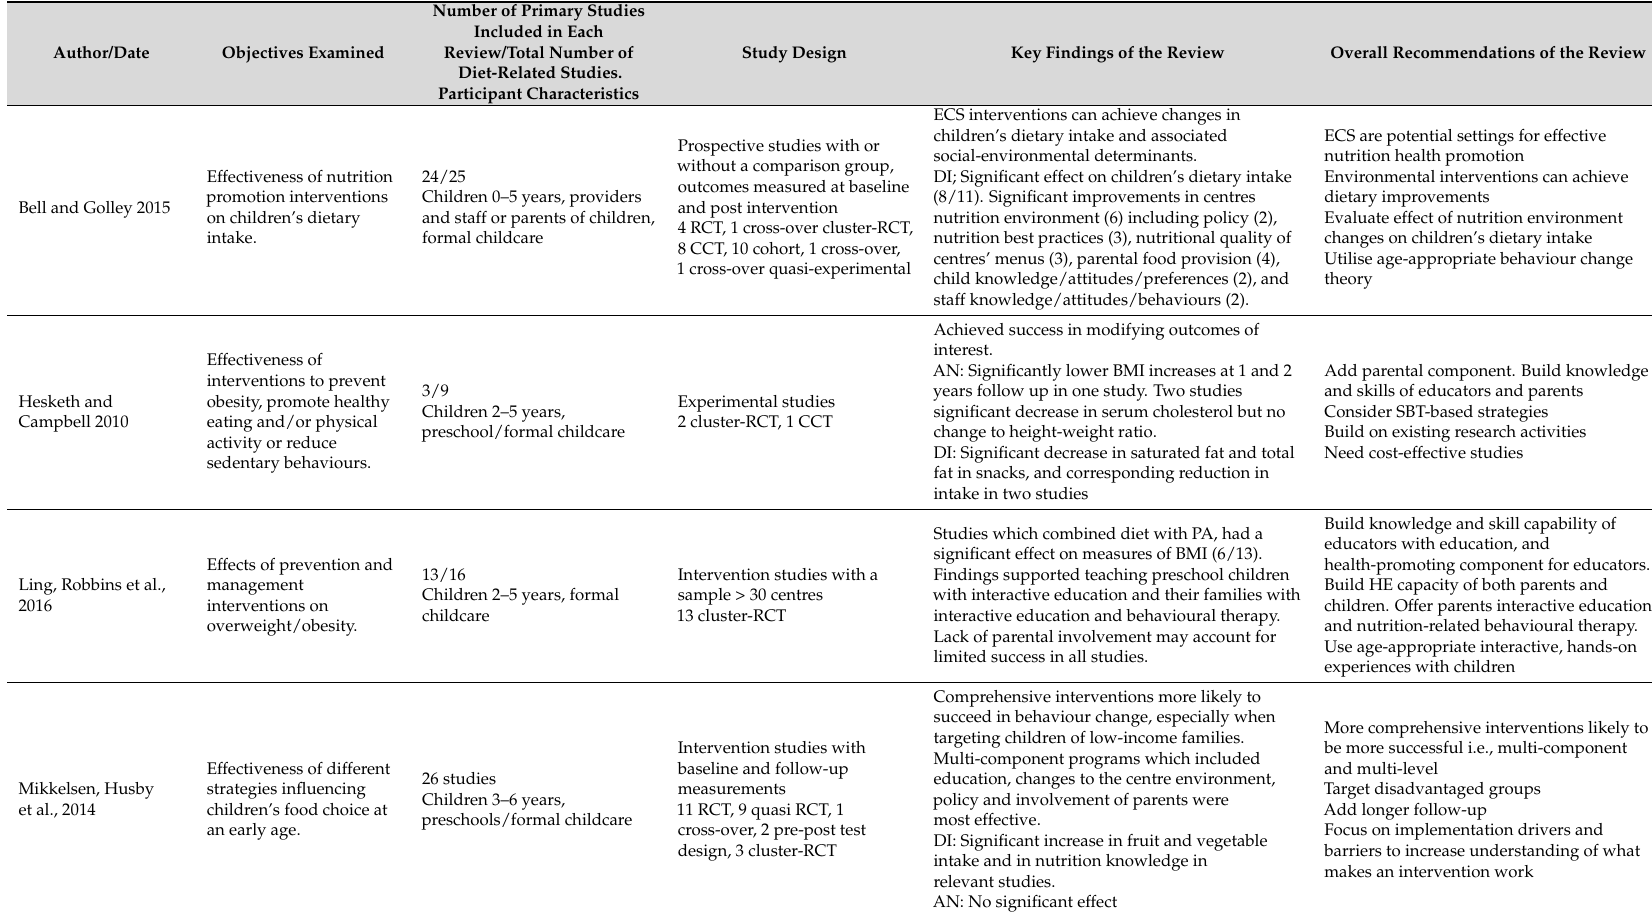
Table 1. Key Characteristics of the Selected Systematic